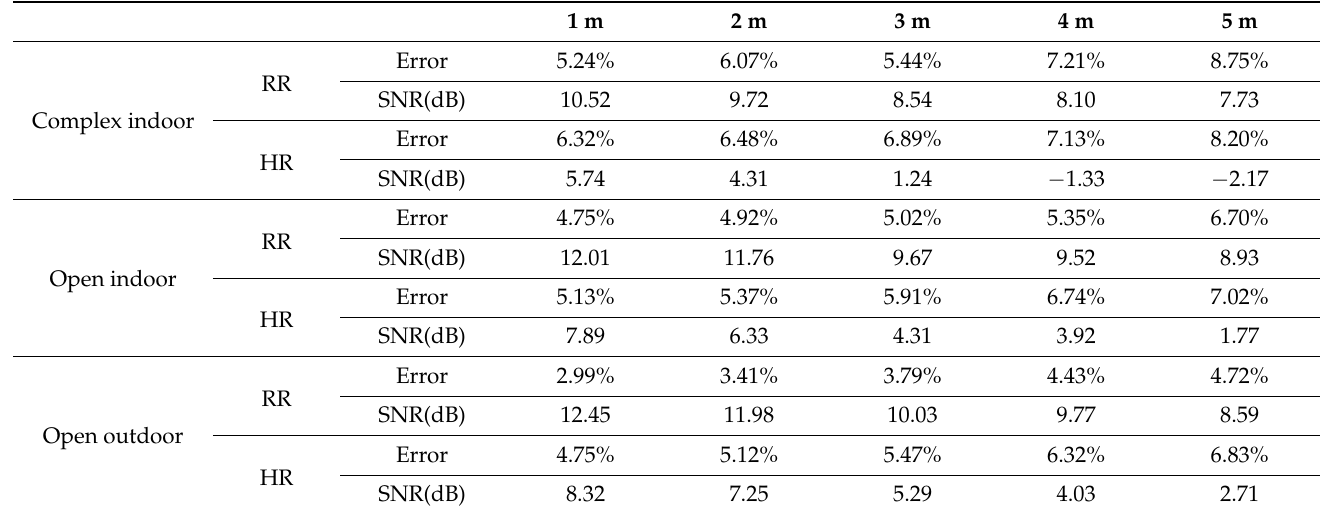
Figure 5. Vital signs signals obtained by IR − UWB radar in Outdoor open environment. ( a ) Time domain at different distances. ( b ) Frequency domain at different distances.